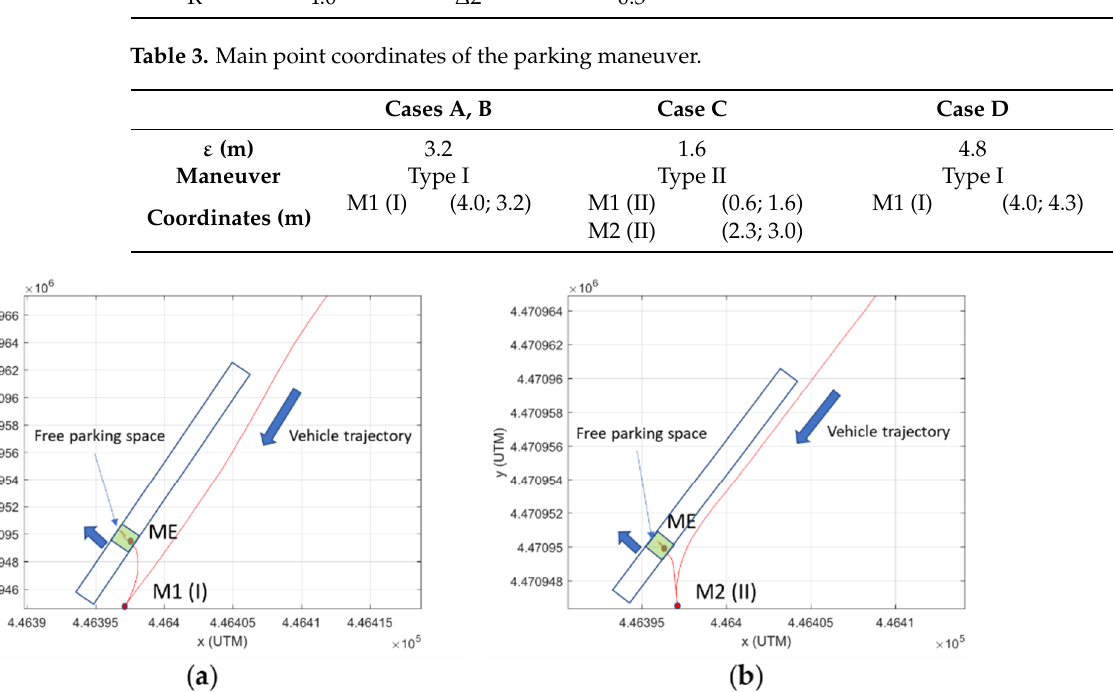
Figure 10. Trajectories during parking maneuvers. ( a ) Maneuver type I in Case A; ( b ) Maneuver type II in Case